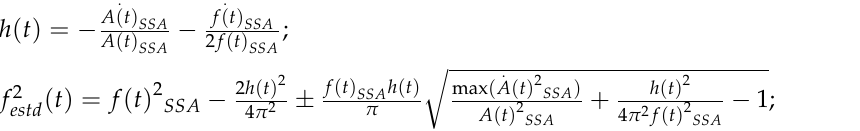
Figure 5. The window length is set to be 800 sample points in the SSA algorithm. For the ideal signal, the Backbone curve and FRF curve are both extracted accurately by the proposed method. Significant improvements are obtained for the noisy signals case. Unlike the FREEVIB algorithm, when the SNR becomes relatively low, there are no longer noticeable fluctuations in IFs. Consequently, the calculated Backbone curves remain legible and accordant with the theoretical values. As the SNR decreases, there are some fluctuations in the computed FRFs, but it is still possible to effectively represent the system dynamics.